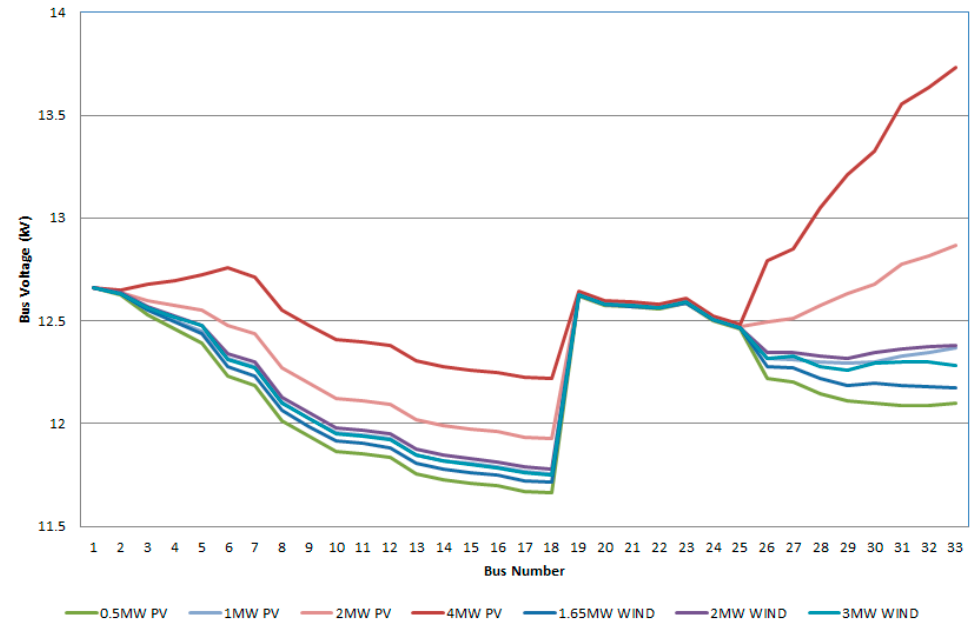
Figure 6. Voltage profiles of network buses when different DG unit sizes have been connected at bus 33.